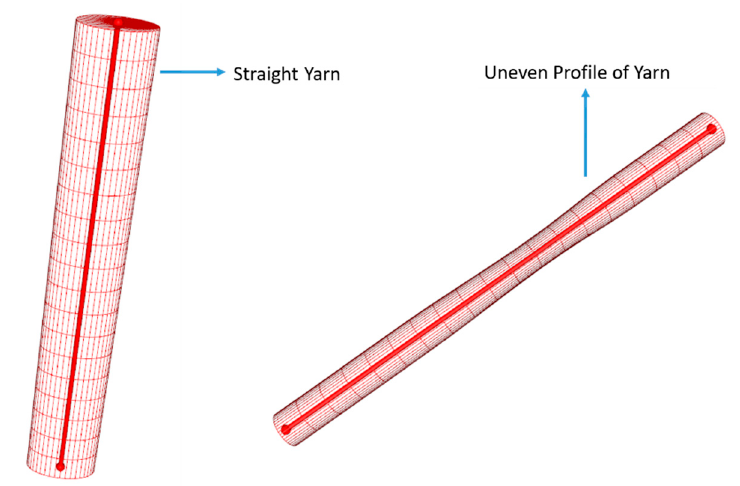
Figure 3. Profiles of yarn.